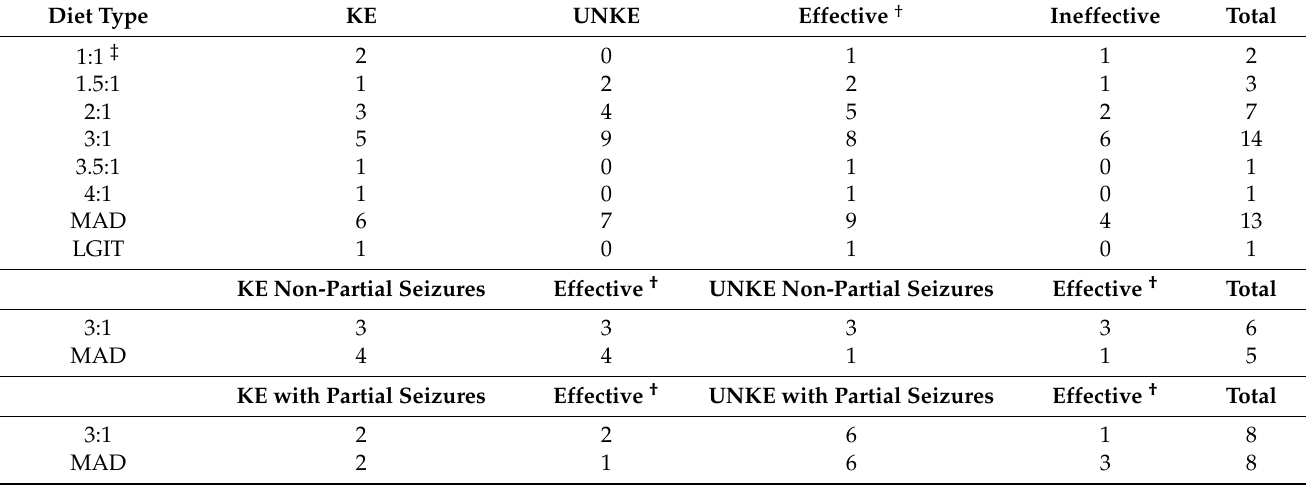
Table 4. The type of ketogenic diet treatment used in